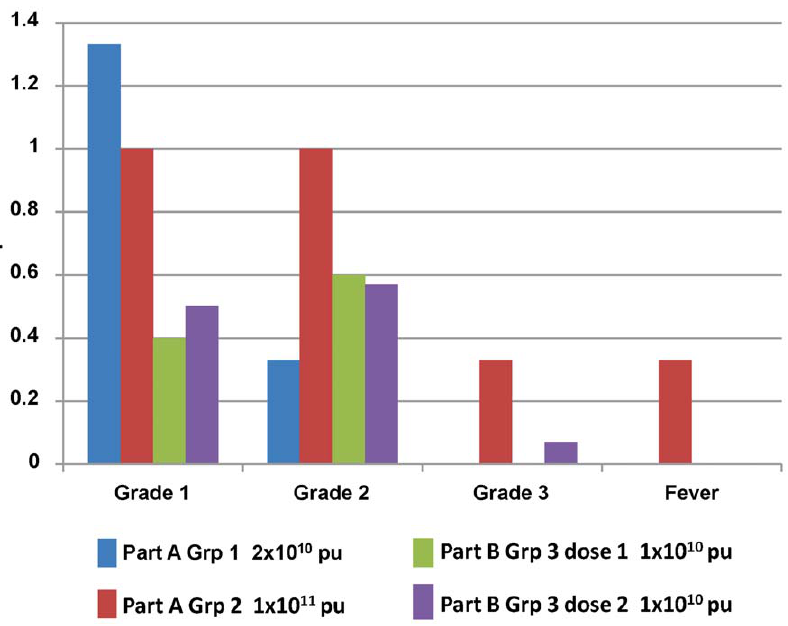
Figure 2. Frequency of Selected Adverse Events Recorded from Day of Immunization through 14 days post-immunization for Groups 1, 2 and 3. The frequencies of pain, malaise, headache and myalgia (combined) by severity grade, and, separately, of objective fever (one grade 1 and one grade 2) are shown for each vaccine group.